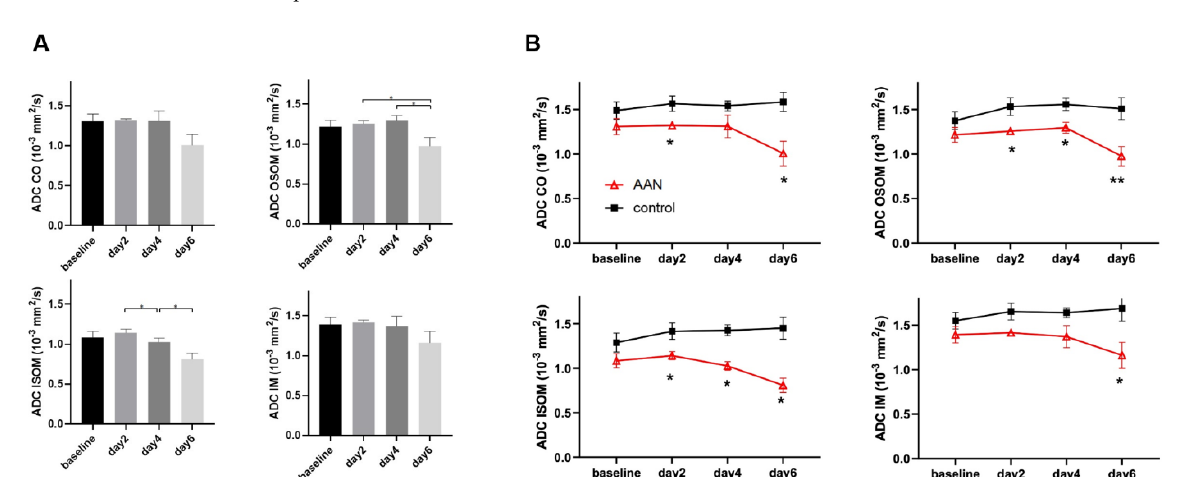
Figure 5. Statistical analysis of apparent water diffusion coefficients (ADCs) for the AAN group ( A ) and the control group ( B ). ** p < 0.01, * p < 0.05. CO, cortex; OSOM, outer stripe of outer medulla; ISOM, inner stripe of outer medulla; IM, inner medulla.